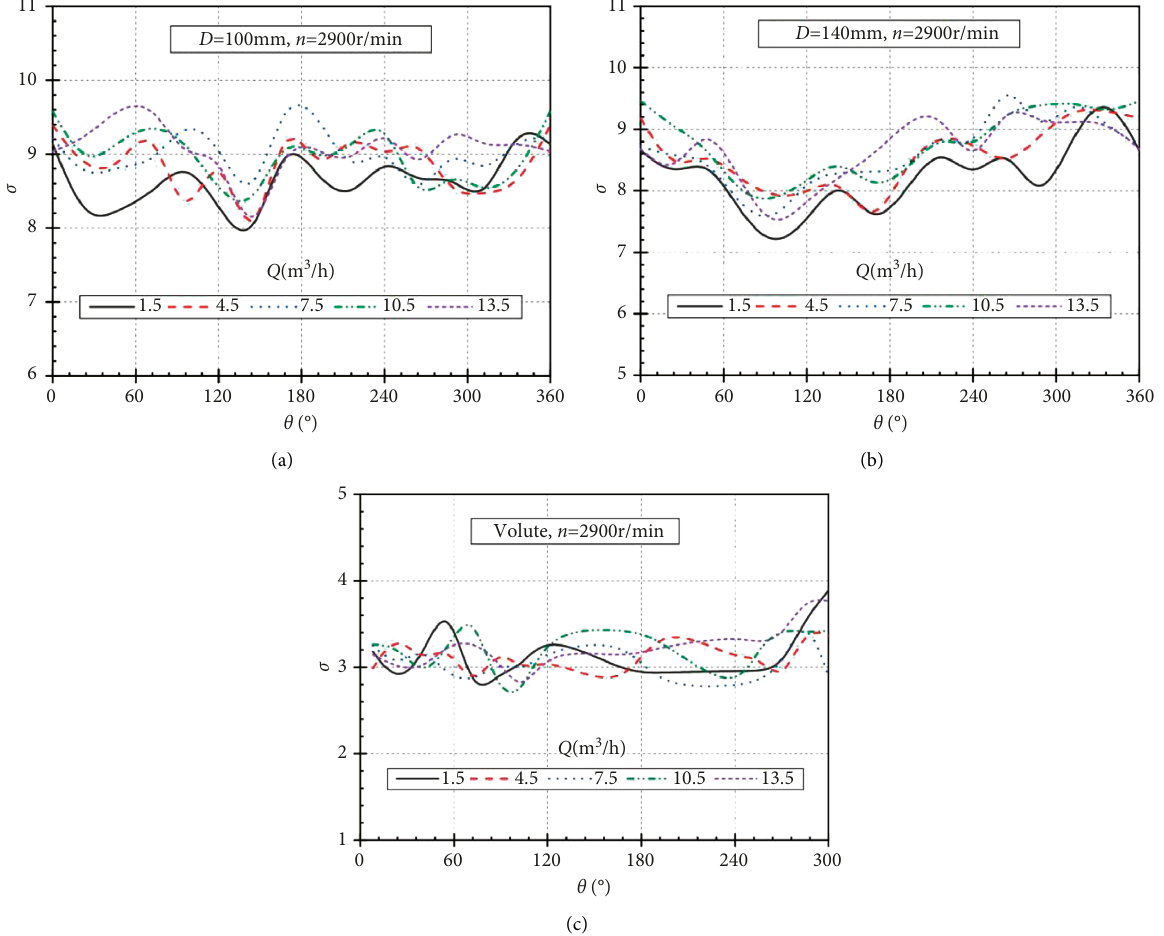
Figure 14: Standard deviation